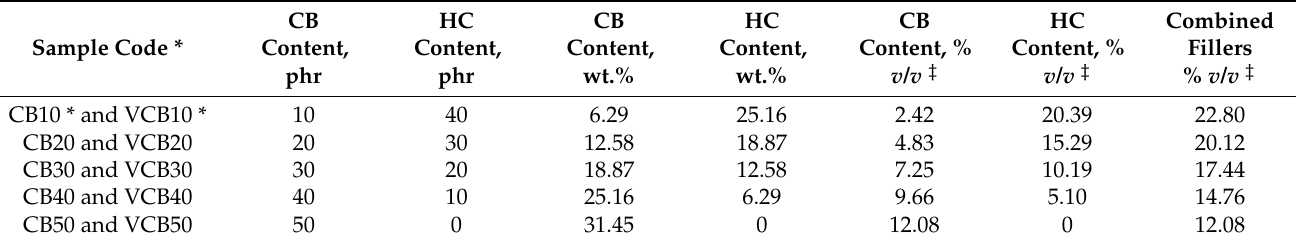
Table 2. Labeling of the prepared rubber samples and the content of co-fillers in them expressed in phr, wt.%, and % v / v .